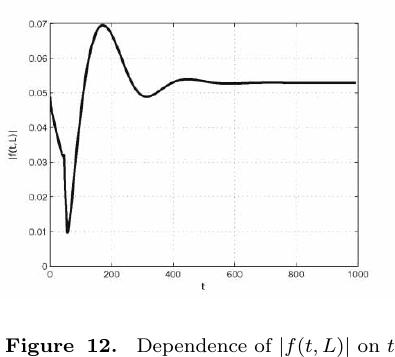
Figure 12. Dependence of | f ( t,L ) | on t (new), λ = 0, L = 113 . 7, τ = 0 , 0496, h = 0 , 42.